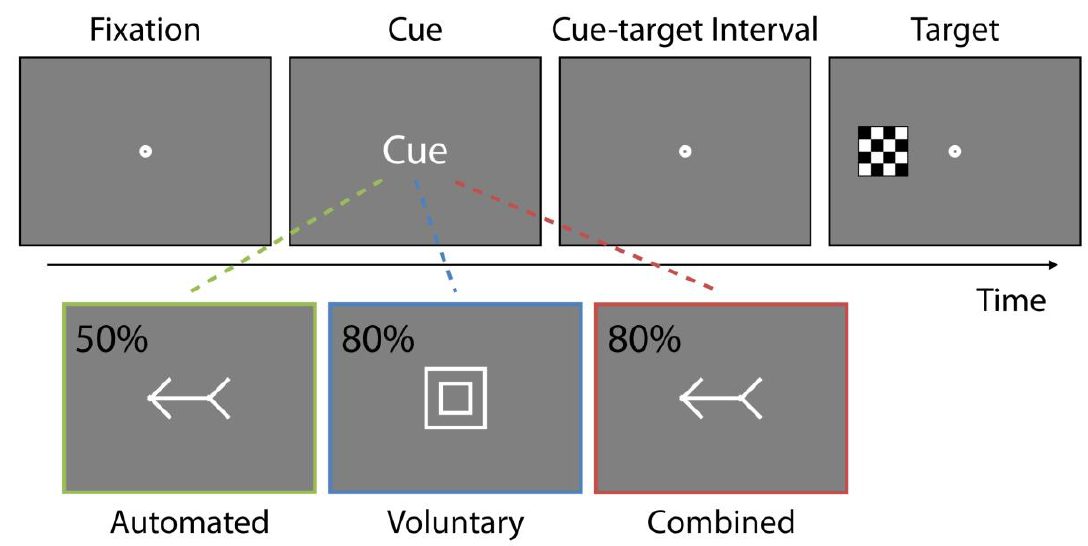
Figure 1. Stimuli and an example trial sequence. Each trial began with a fixation screen for 600 ms. Then, depending on the condition, a central shape or arrow cue, indicating a left or right target location, was presented for 100 ms. The display then reverted to the fixation screen for a randomly determined time interval ranging from 250 to 650 ms, thus making up the 350 to 750 ms cue-target time intervals. A response target was presented peripherally on the left or right of fixation and remained on the screen until response was made or 2700 ms had elapsed. Note that stimuli are not drawn to scale and that condition color-coding was not used during the procedure. Note that percentages listed for each attention condition indicate the accuracy of the cue in indicating the correct location of the upcoming